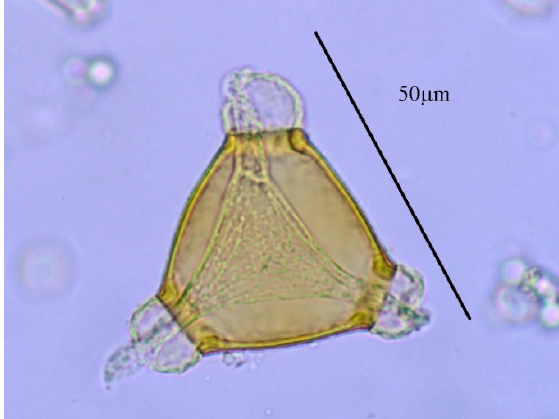
F IGURE 4. Image of Proteaceae pollen (most likely Grevillea parviflora subsp. parviflora) from the propolis samples from Tetragonula carbonaria beehives at 40X